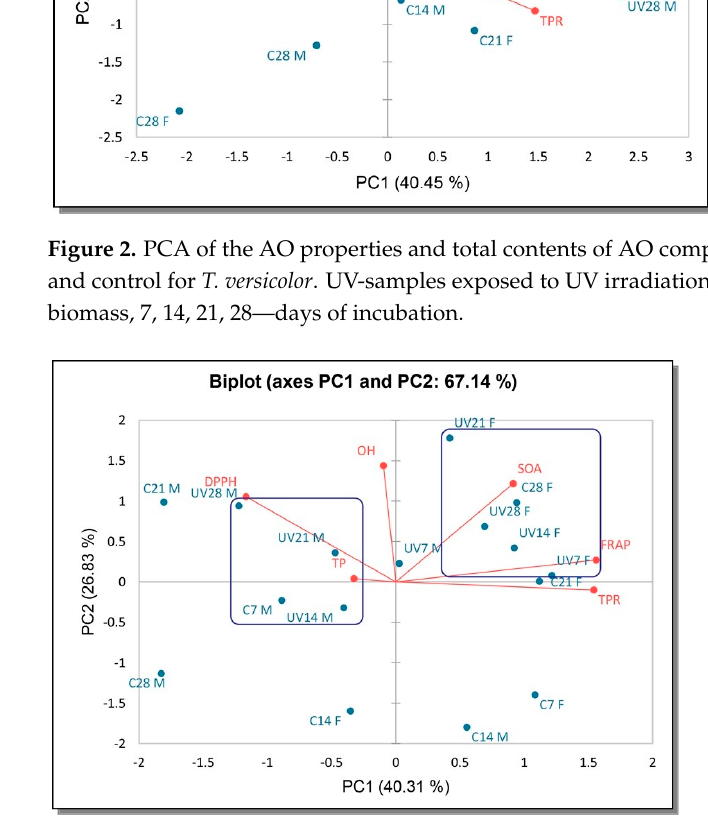
Figure 3. PCA of the AO properties and total contents of AO components of irradiated UV samples and control for F. velutipes . UV-samples exposed to UV irradiation, C-control, F-filtrate, M-mycelia biomass, 7, 14, 21, 28-days of incubation.